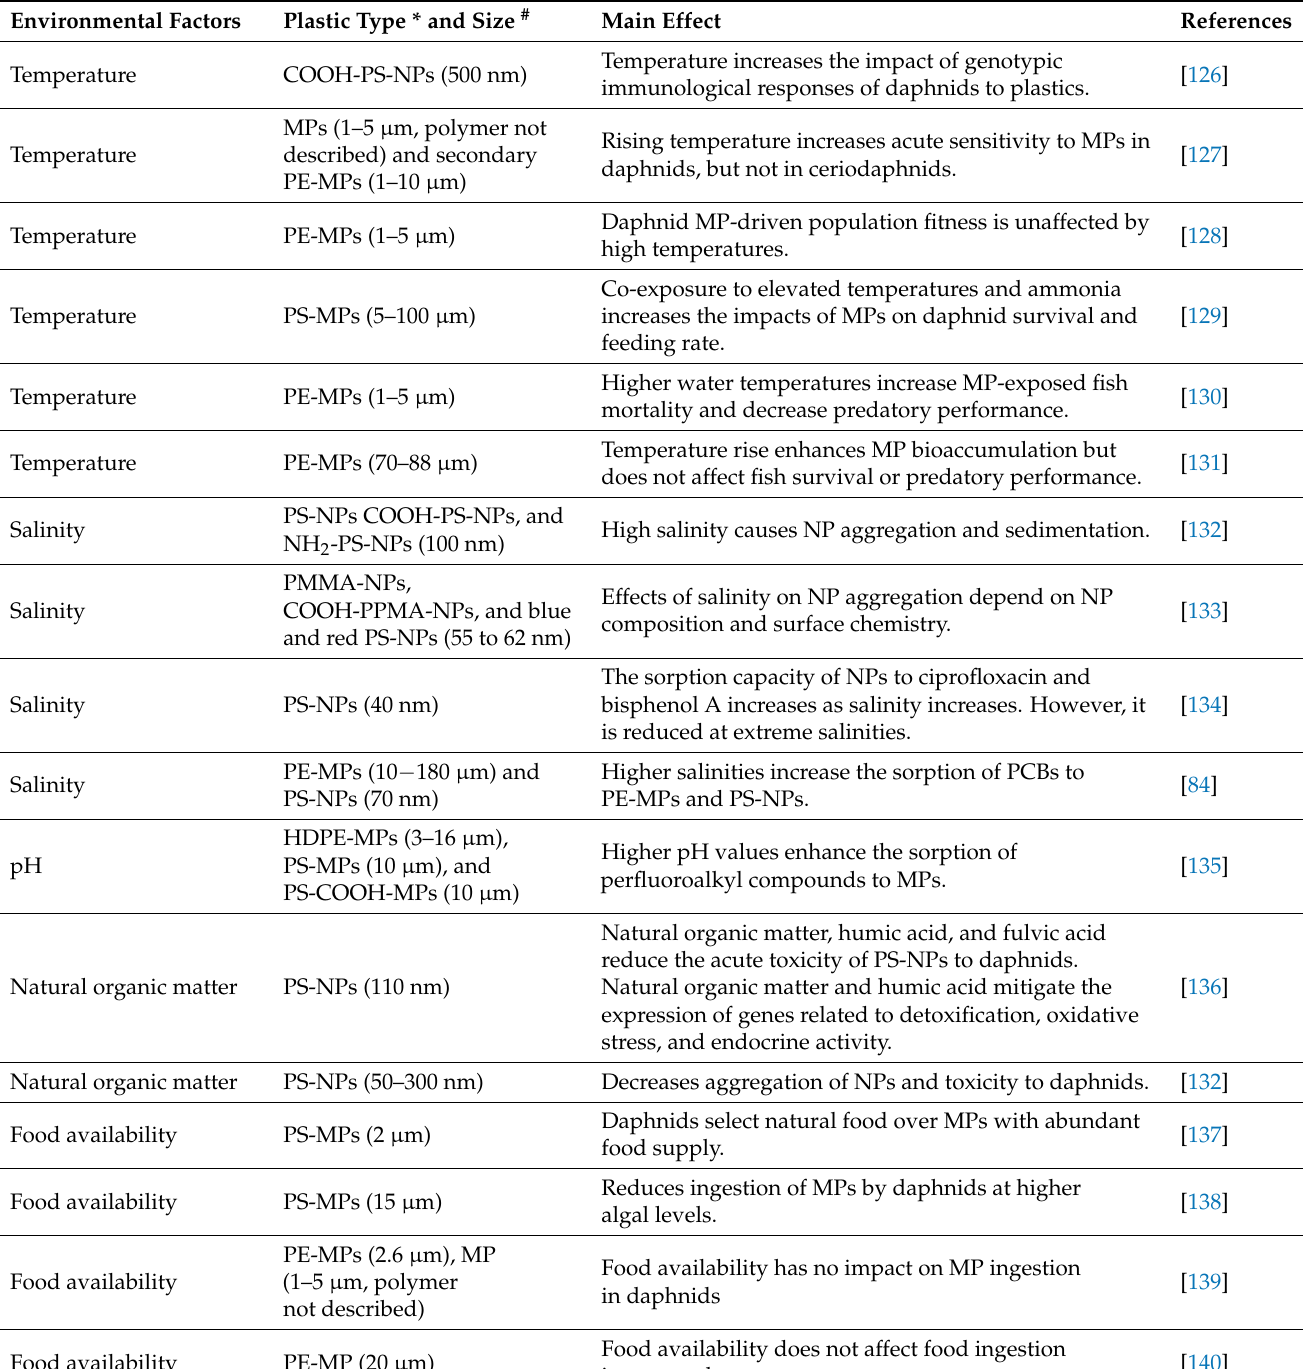
Table 2. Summary of the interactive effects of nanoplastics (NPs) and other small plastics (<100 µ m) with environmental parameters or